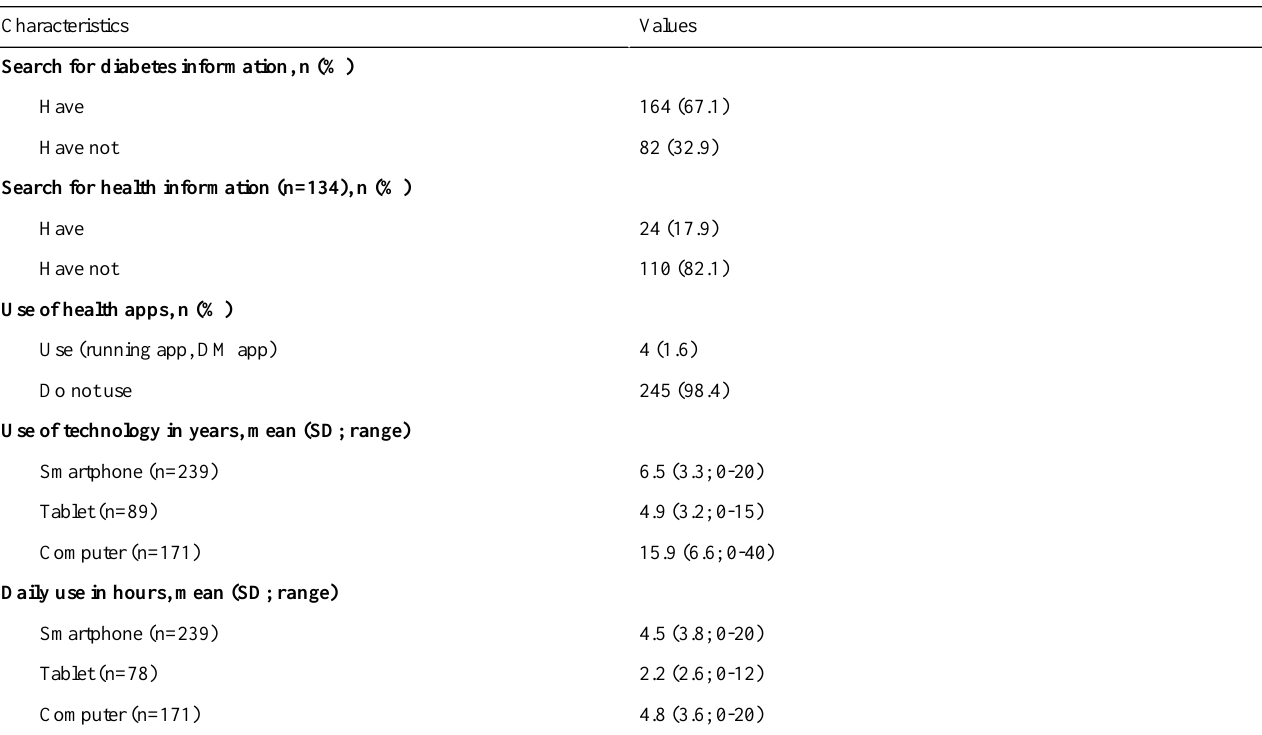
Table 2. Participant habits regarding online health information seeking and the use of mHealth apps (n=249). ValuesCharacteristics